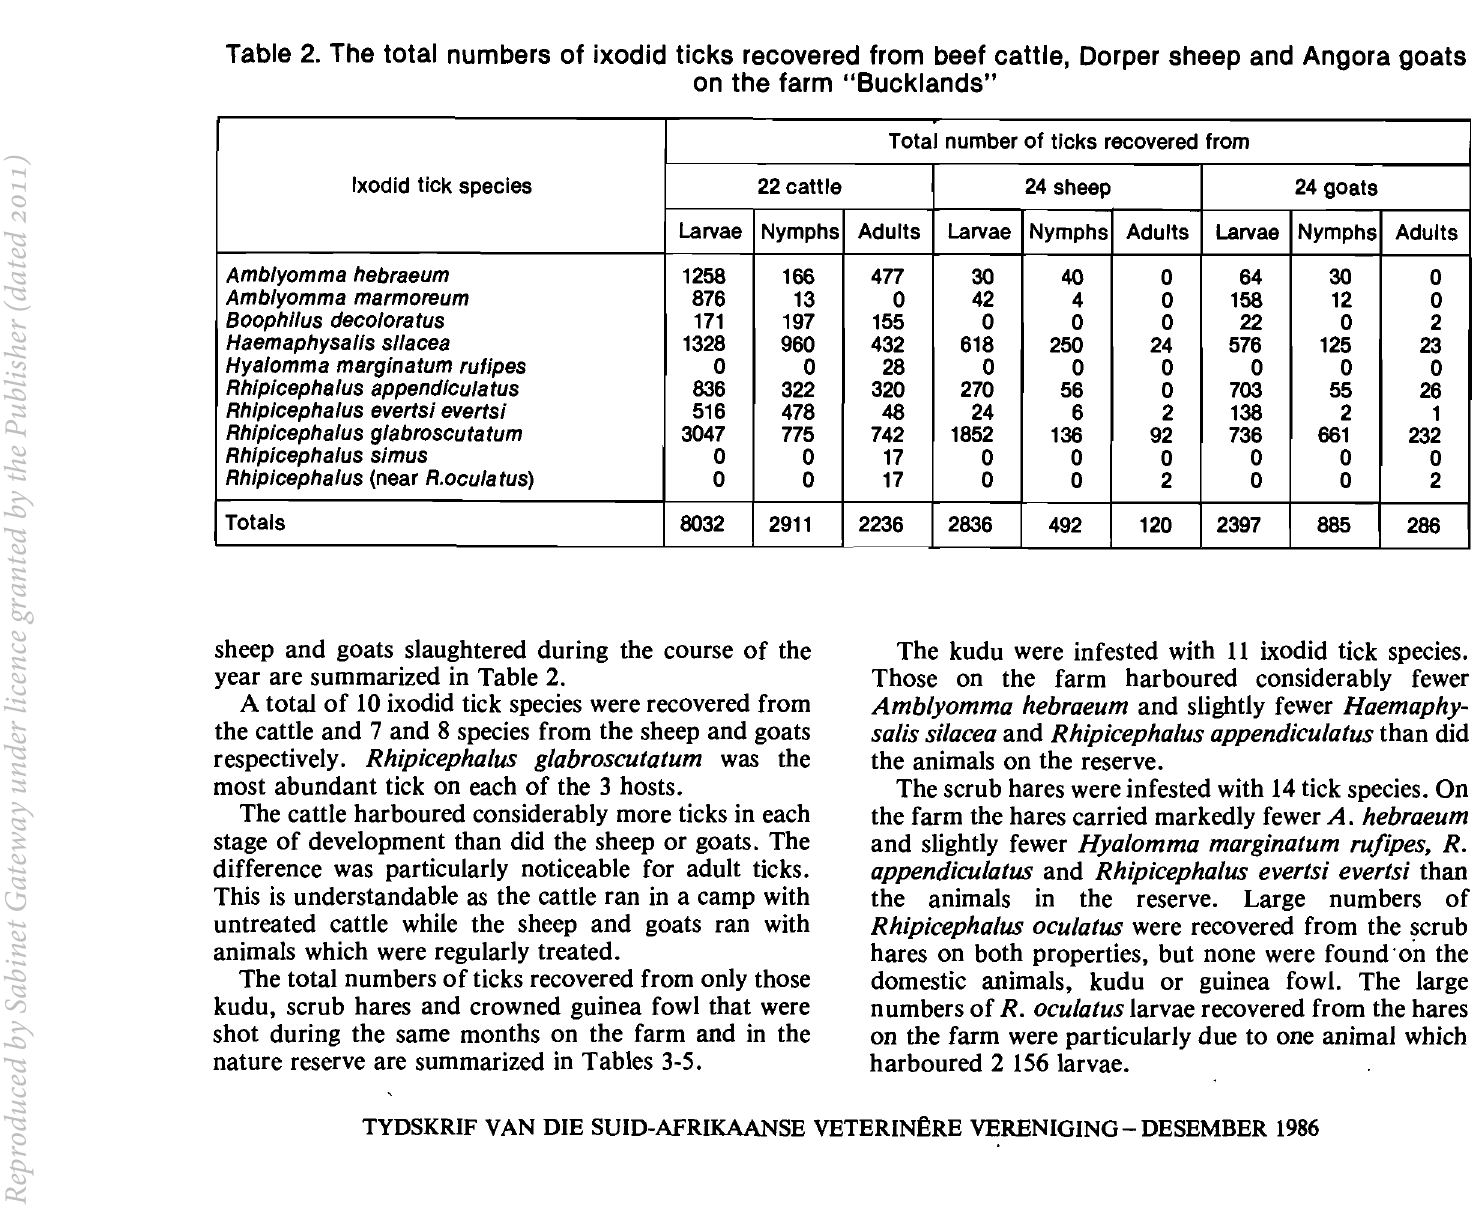
Total numbers available for